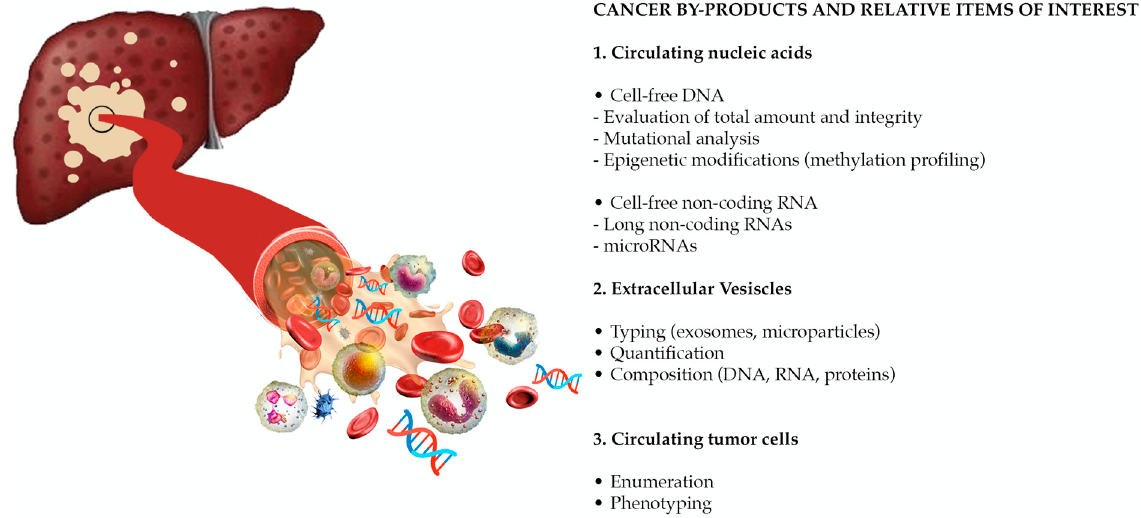
Figure 1. Liquid biopsy is the molecular analysis of cancer by-products released in the bloodstream. Novel potential biomarkers are represented by circulating nucleic acids, extracellular vesicles (EVs), and circulating tumor cells (CTCs). (Adapted from Labgaa et al. [24]).